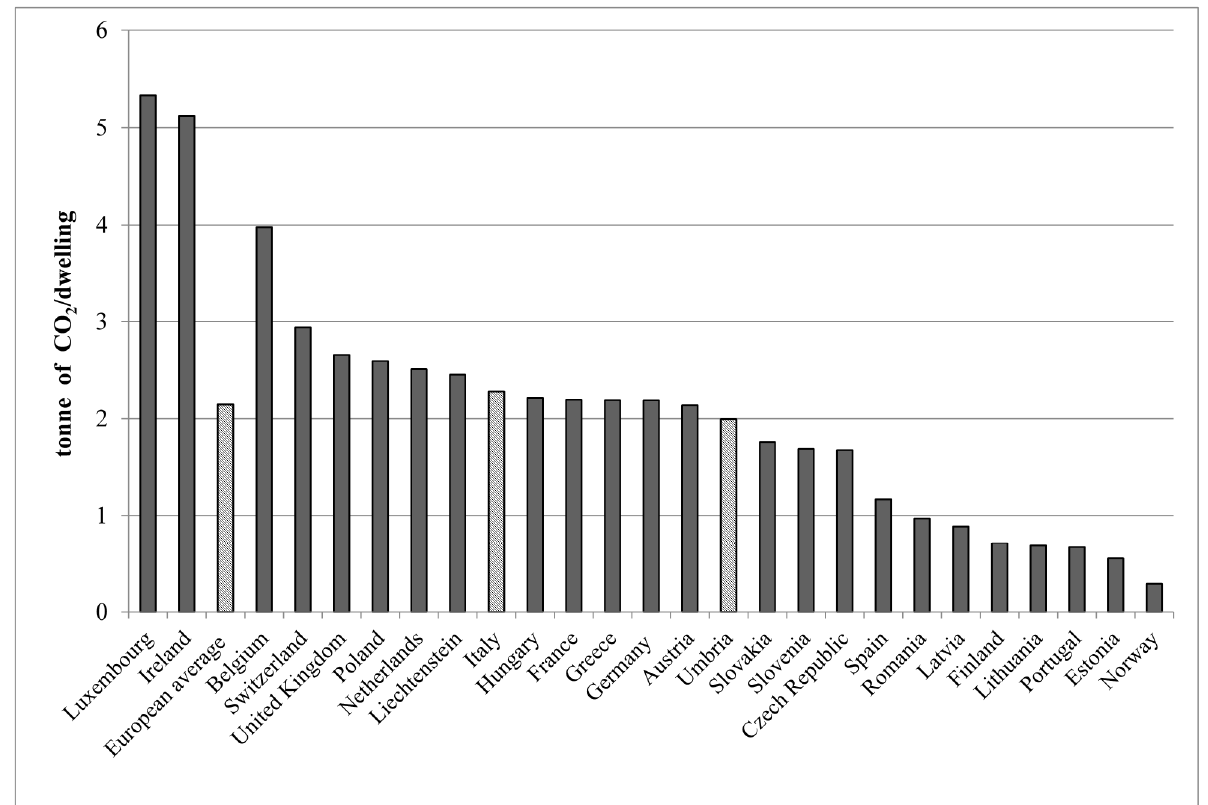
Figure 9. Annual average CO 2 emissions per dwelling by country in